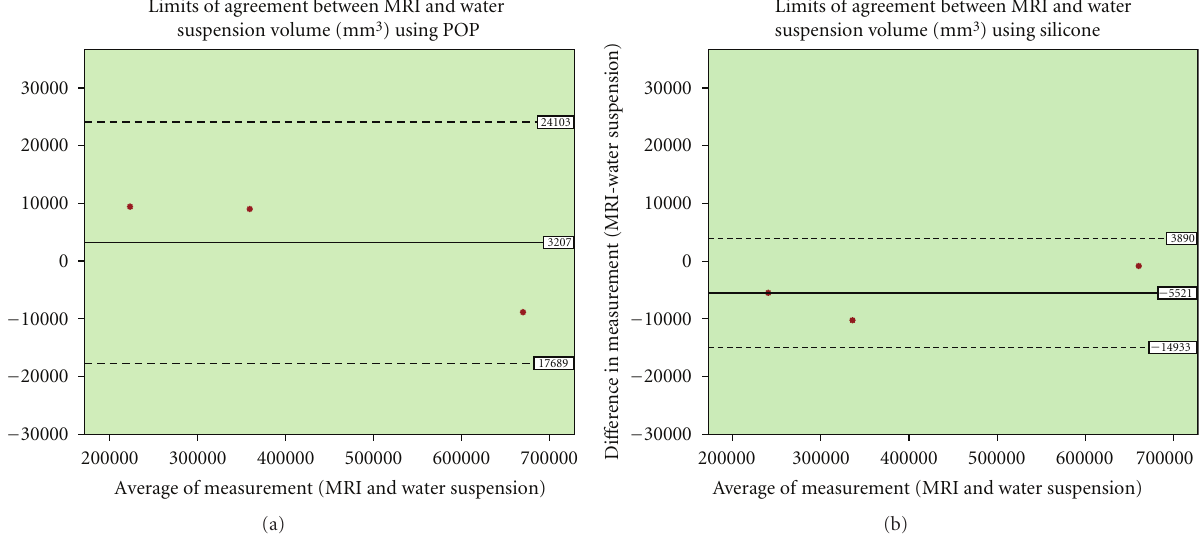
Average of m easure m ent (MRI an d w ater